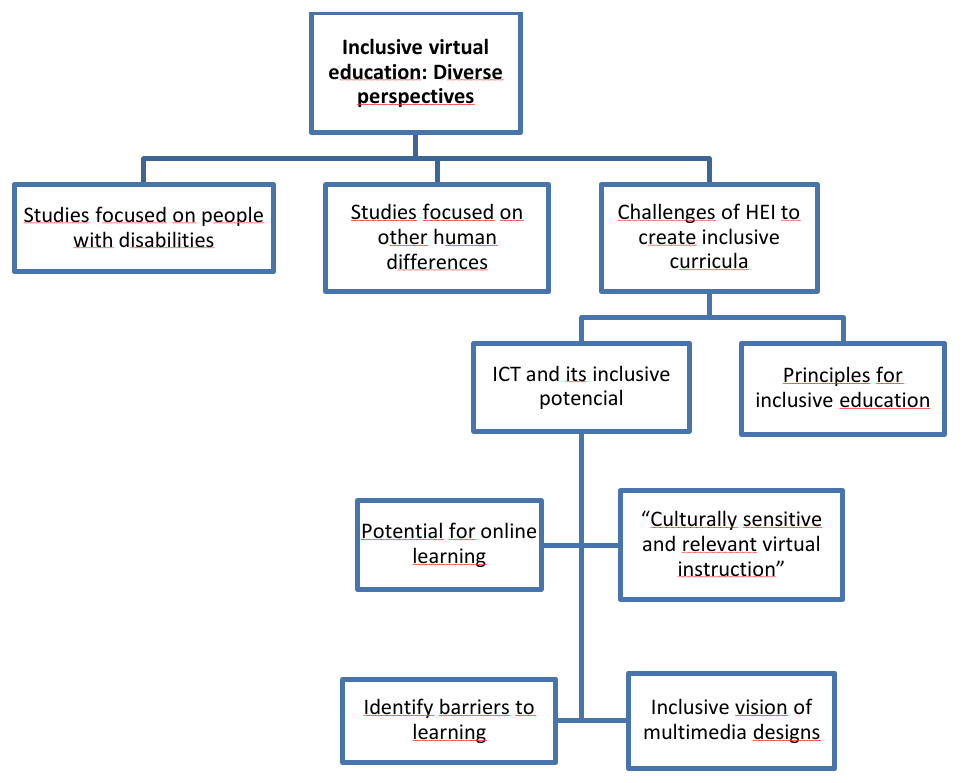
Figure 1 . Main elements of inclusive virtual education with central category highlighted. This mind map illustrates the categorization process, including the central category and its subcategories. The text within quotation marks corresponds to the codes "in vivo," i.e., to an expression taken textually from the articles reviewed, while the others are constructions or conceptual codes generated by the researcher during the analysis